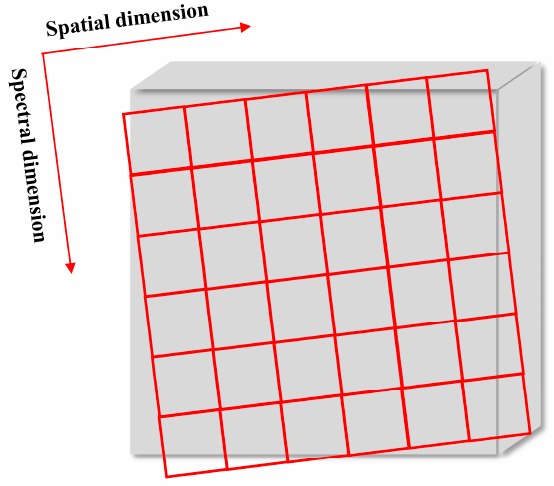
Figure 2. Diagram of detector rotational misalignment.